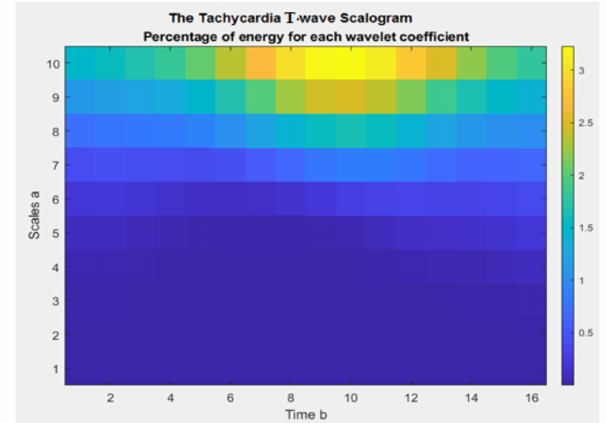
Figure 8. The Tachycardia T-wave